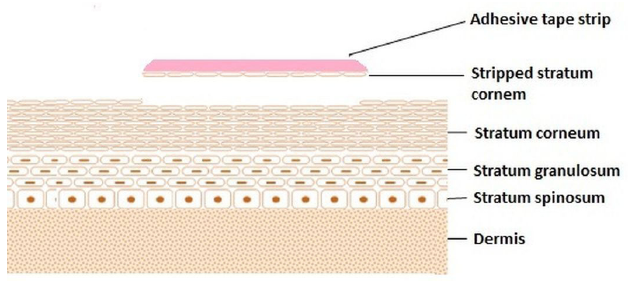
FIGURE 1 - Adhesive tape stripping of stratum